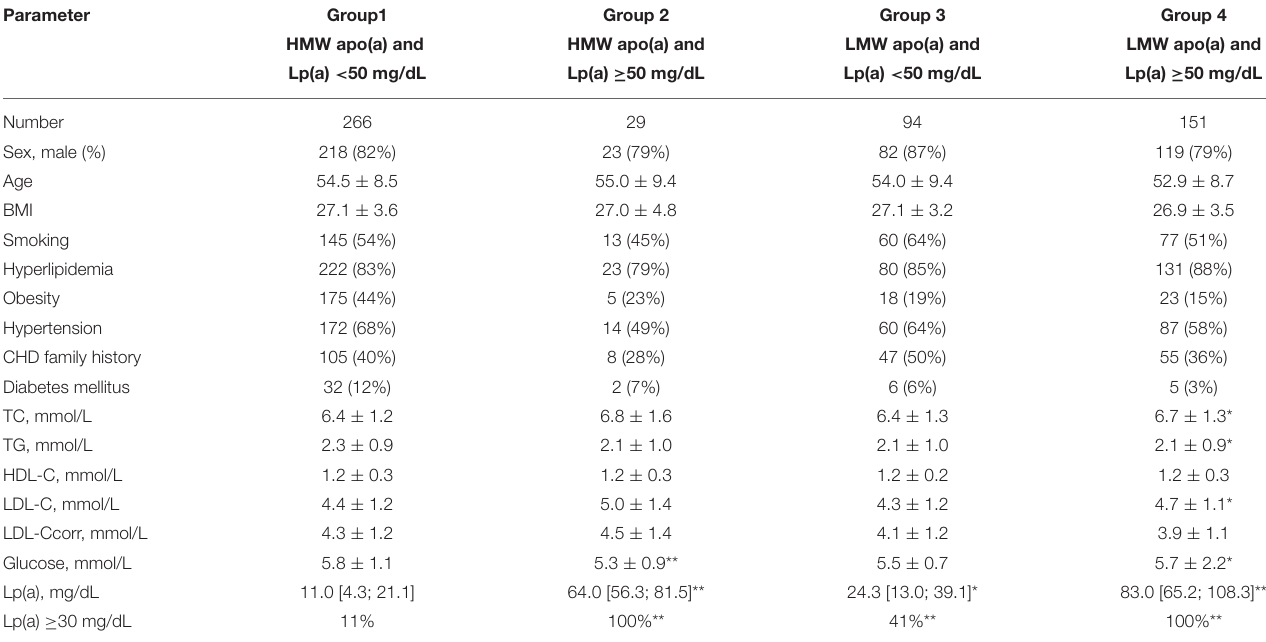
TABLE 1 | The clinical and biochemical characteristics of patients with different lipoprotein(a) levels and apolipoprotein(a) phenotype. Parameter